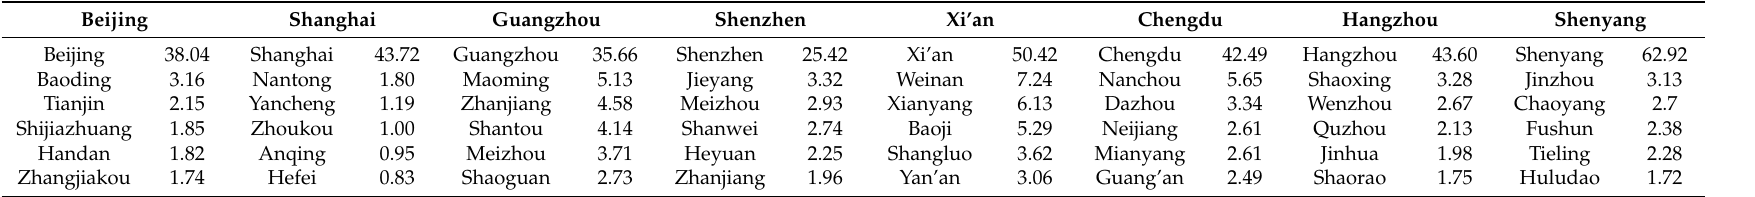
Table 1. hukou origination cities of representative destination cities (in percentage).